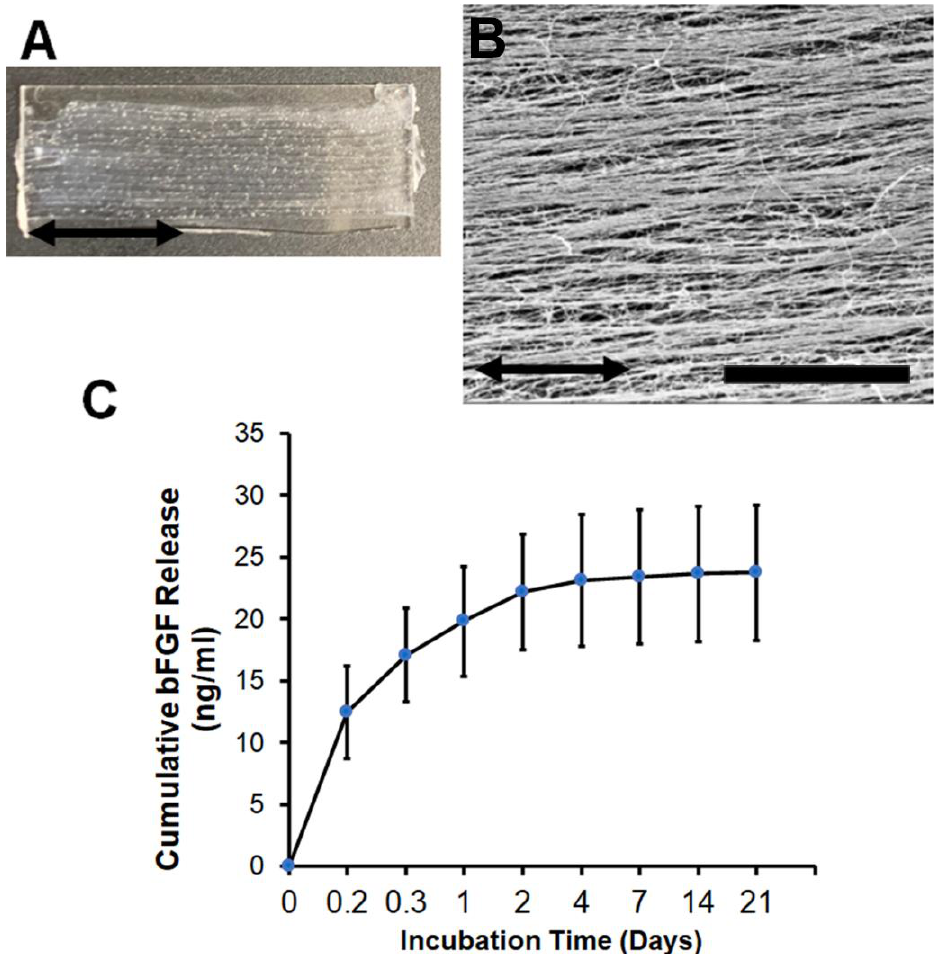
Figure 1. Aligned nanofibrillar scaffold fabrication and characterization. ( A ). Gross image of aligned nanofibrillar collagen scaffold bundle extruded and adhered onto a glass substrate. ( B ). Scanning electron microscopy image of aligned collagen scaffolds show organized nanofibrils in parallel. ( C ). Cumulative bFGF release from aligned nanofibrillar scaffolds over 21 days. Data are shown as mean ± SD ( n = 5–6). Scale bar: 10 µm.